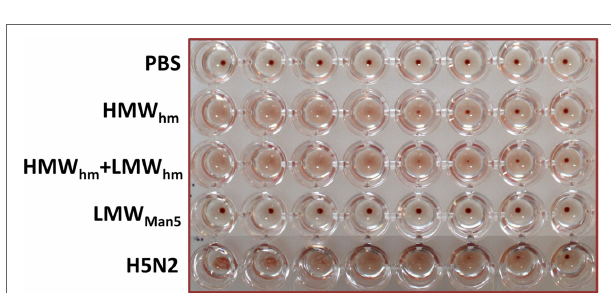
FigUre 6 | hemagglutination of chicken red blood cells by the h5 hm and h5 Man5 proteins . Twofold dilution of the H5 antigens were incubated with 1% chicken erythrocytes (30 min, RT). Two forms (HMW and LMW oligomers) of H5 hm antigen were tested. As a positive control, an inactivated H5N2 virus (A/chicken/Belgium/150/1999) was